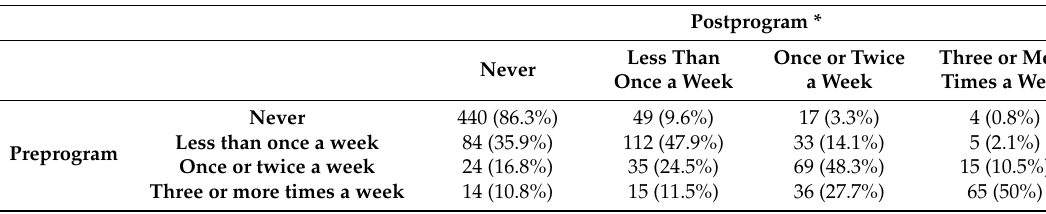
Table 4. The number of participants reporting never, less than once a week, once or twice a week and three or more times a week relating to sugar-sweetened drink frequency. Percentages refer to the percentage of the specific preprogram group.